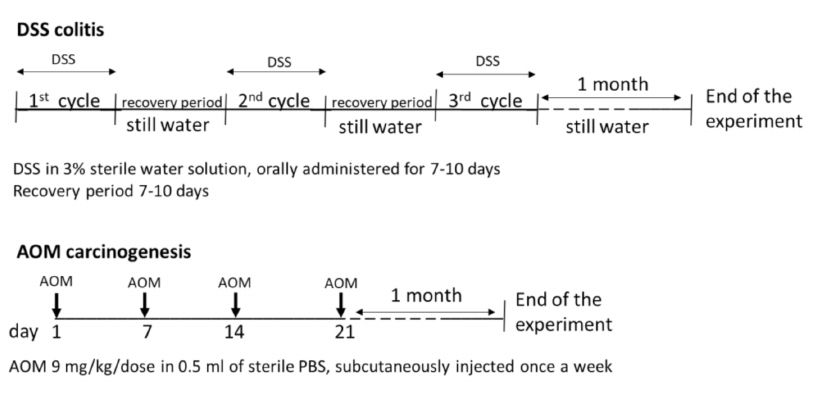
Figure 2. Design of the